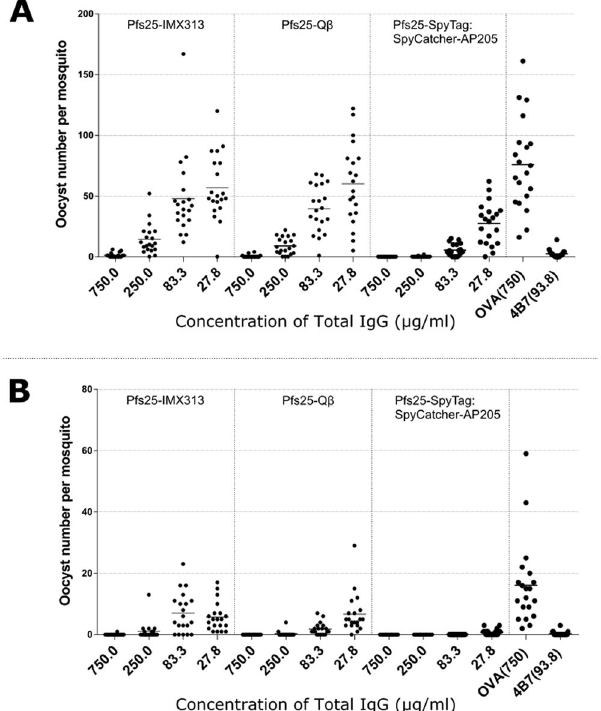
Figure 4. Transmission blocking efficacy of anti-Pfs25 IgG induced by nanoparticle vaccines. Total IgG was purified from the pooled serum of each group (3 weeks post boost). The purified IgG was mixed with P. falciparum NF54 cultured gametocytes and fed to A. stephensi mosquitoes (n = 20 per test group) in two independent SMFA experiments. ( A , B ) IgG from ovalbumin-immunized mice was used as a negative control; the transmission blocking anti-Pfs25 mAb 4B7 was used as a positive control. Midguts were dissected 7 days post-feeding. Data points represent the number of oocysts in individual mosquitoes and the lines show the arithmetic mean ( A , B ). x-axis values are μ g/ml total IgG in the